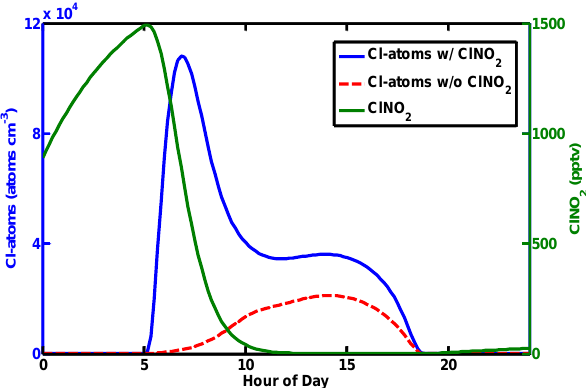
Fig. 1. Model output for the analysis period of a model run show- ing ClNO 2 mixing ratios (heavy green line, right y axis) and Cl · concentrations for the case including ClNO 2 formation (heavy blue line, left y axis) and the case excluding ClNO 2 formation (dashed red line, left y